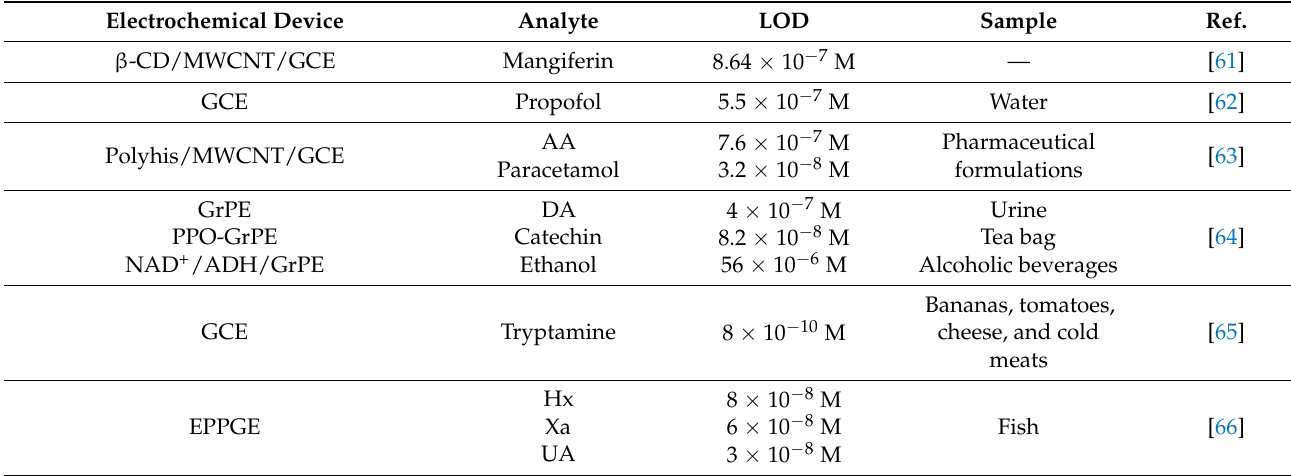
Table 4. Electrochemical sensors/biosensor for natural and synthetic antioxidants detection developed in Argentina in the last 10 years. See the abbreviation list at the end of the